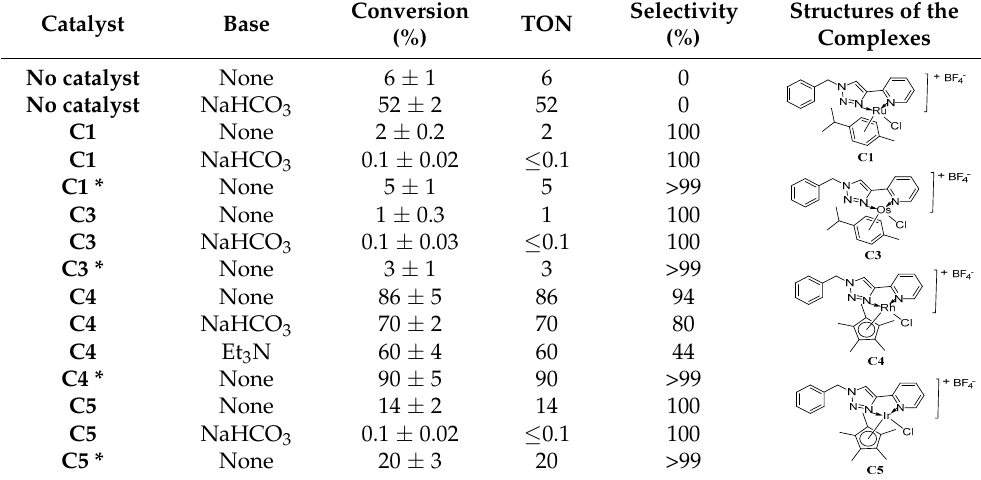
Table 2. Results for the catalytic reduction of pyruvate to lactate under pseudo-physiological conditions a . Catalyst